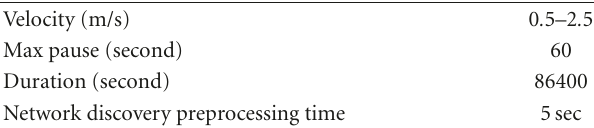
Table 6: Parameters of random waypoint mobility model. Velocity (m/s) 0 . 5–2 . 5